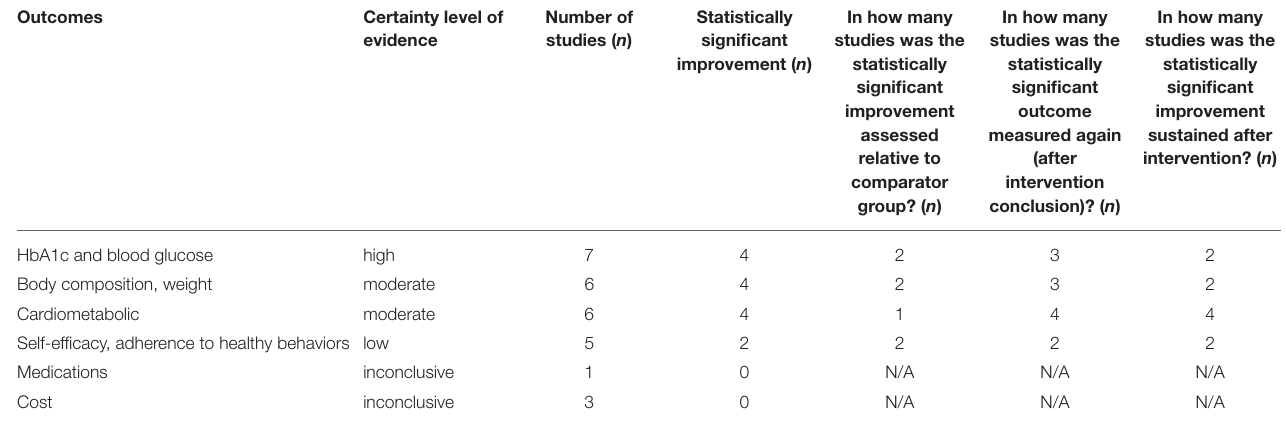
TABLE 2 | Certainty of evidence